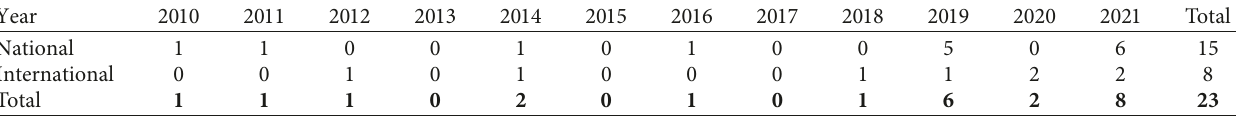
Table 1: The number of research reports related to IBL in Ethiopia from 2010–2021.